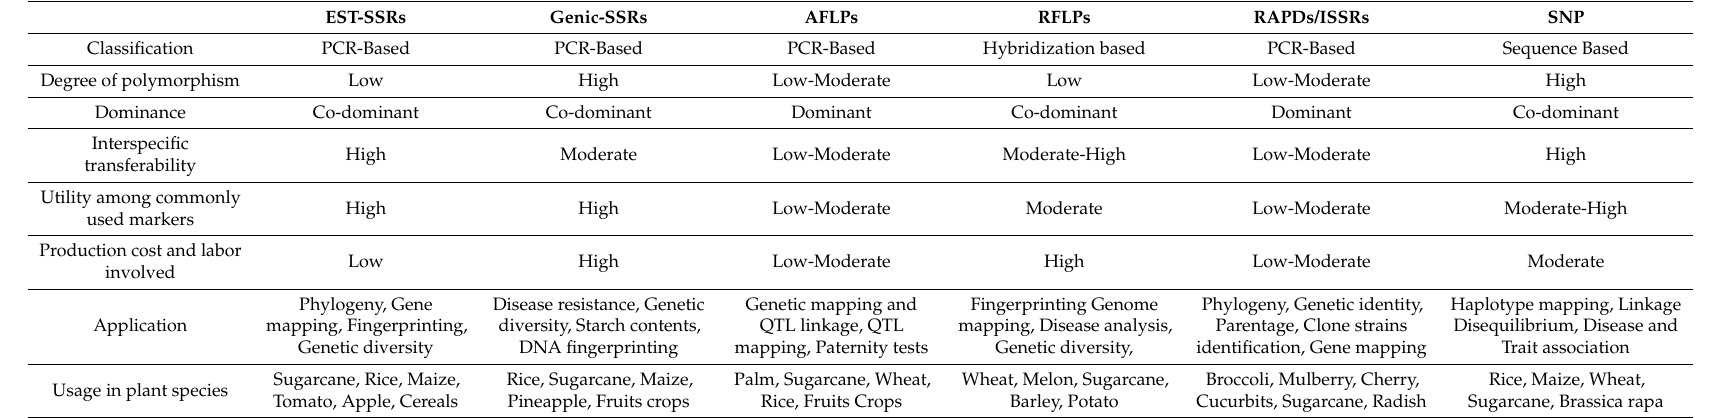
Table 3. Comparison of different types of molecular markers in plant